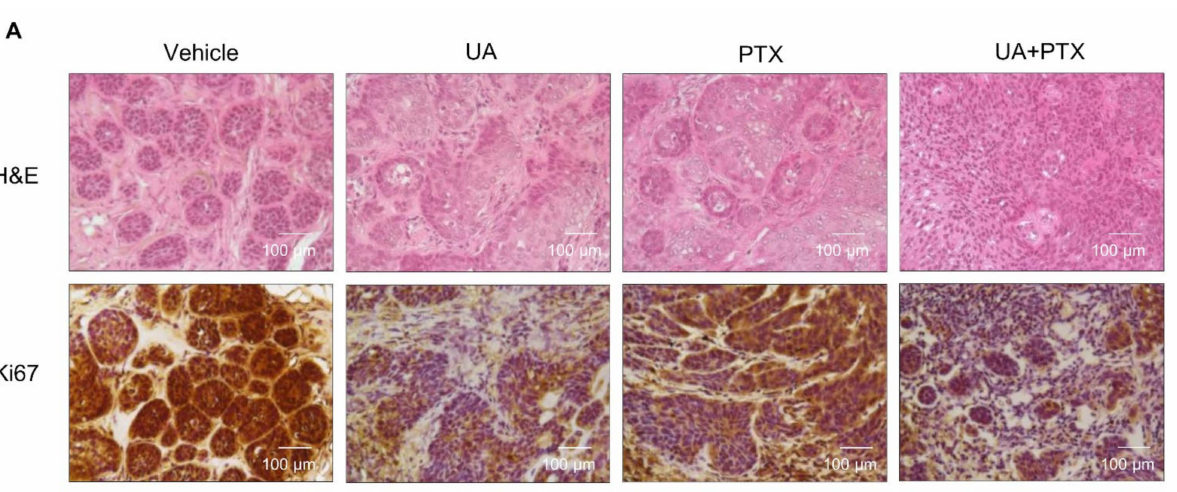
Figure 8. UA and PTX inhibited tumor growth in TE-8 xenografts in vivo . Body weight ( A ) and tumor volume ( C ) were measured every three days. Tumor weight ( B ) and tumor size ( D ) were measured after euthanasia. # , UA-treatment group compared with the UA plus PTX combination treatment group; a , PTX treatment group compared with the UA plus PTX combination treatment group; *, compared with the vehicle group. # , * p < 0.05; ## , aa , ** p < 0.01 and *** p < 0.001 compared with the vehicle. Vehicle, DPBS; UA, ursolic acid 30 µ M; PTX, paclitaxel 25 nM; UA+PTX, combination treatment of ursolic acid 30 µ M and paclitaxel 25